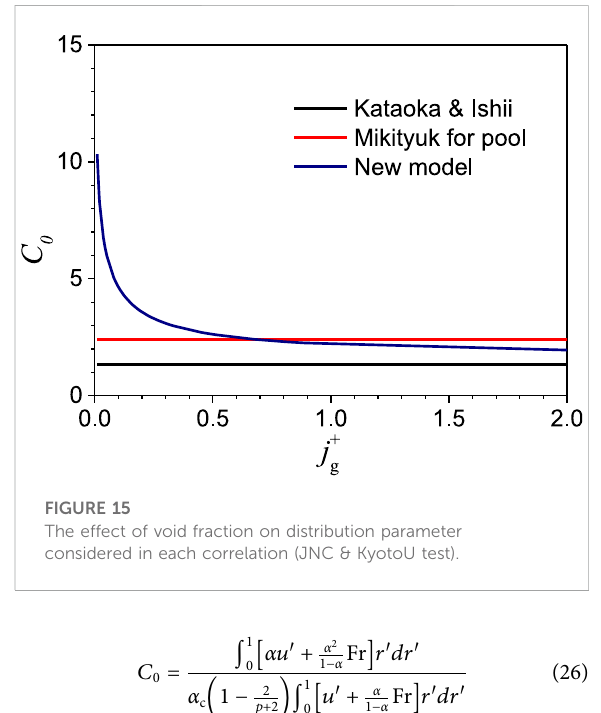
FIGURE 15 The effect of void fraction on distribution parameter considered in each correlation (JNC & KyotoU